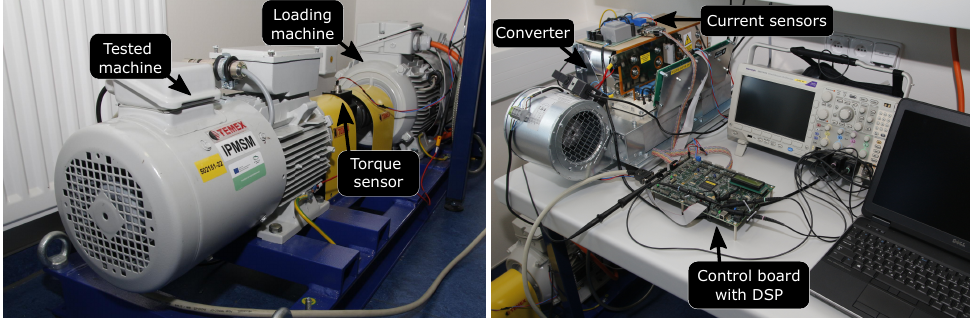
Figure 4. Photo of the test rig with the controlled IPMSM and loading induction machine ( left ), and the controlled converter, current sensors and the control board ( right ).